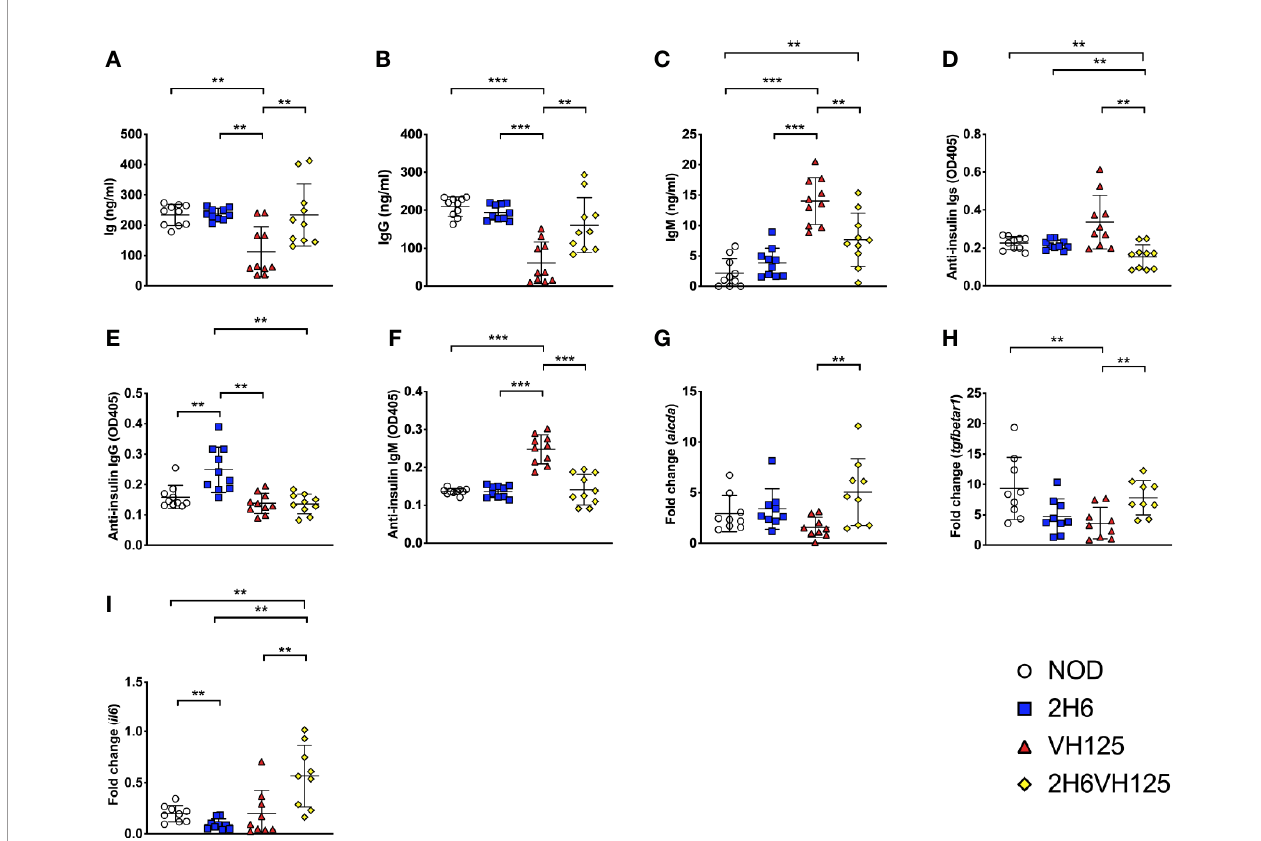
FIGURE 3 | 2H6 TCR transgene promotes IgG class switching in VH125 B cells. (A – F) Sera from 8-week-old mice were tested for total Ig (A) , IgG (B) , IgM (C) , and insulin-speci fi c autoantibodies of the same isotypes (D to F). RNA from splenic B cells was isolated and cDNA synthesized, prior to performing qPCR, to quantify the aicda (G) , tgfbeta1 (H) , and il6 (I) genes. qPCR data are presented as fold change using the 2 - DD Ct method and normalized using the GAPDH values. Data were generated from 9 to 10 individual mice pooled from two independent experiments. Data from left to right: NOD, 2H6, VH125, and 2H6VH125 are shown in this order in each plot. Data from NOD mice are shown as a non-transgenic mouse comparison. Data were assessed for signi fi cance using multiple T tests and FDR correction. **P < 0.001, ***P <